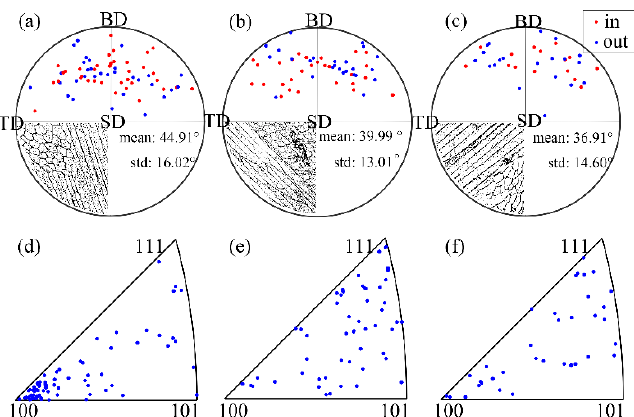
Figure 3. The stereographic pole figures of the growth direction and the stereographic inverse pole figures of the corresponding crystallographic orientation. Both ( a ) and ( d ) are calculated from the substructure in the track at scanning velocity of 0.31 ms − 1 . Both ( b ) and ( d ) are at the scanning velocity of 0.63 ms − 1 . Both of ( c ) and ( e ) are at the scanning velocity of 1.25 ms − 1 . In the pole figures, the inward growth directions are plotted as red points, while the outward growth directions are plotted as blue